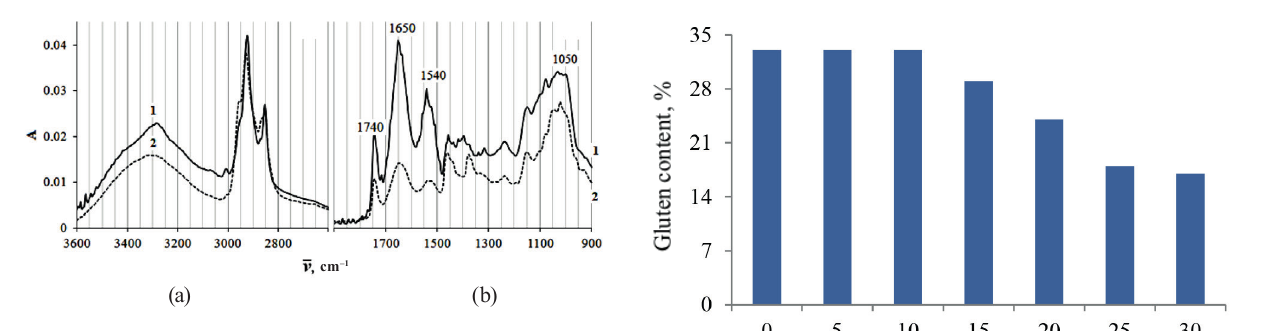
Figure 4 IR absorption spectra of Universal amaranth (1) and Universal amaranth extrudate (2)